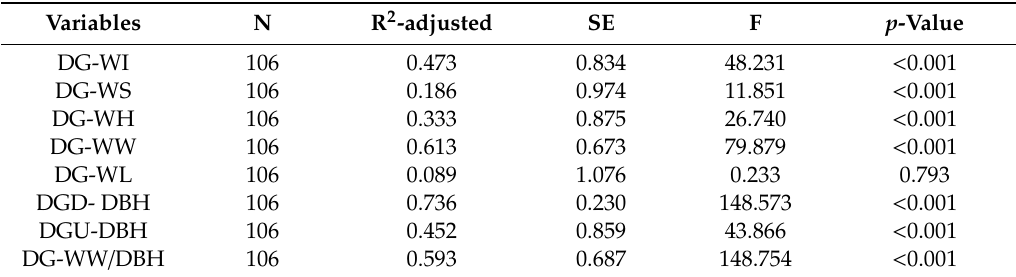
Table 6. Results of regression analysis between characteristics of wounds and trees with diameter growth in loblolly pine trees (WI: wound intensity, WS: wound size, WH: wound height, WW: wound width, WL: wound length, DGD: diameter growth of damaged trees, DGU: diameter growth of undamaged trees), SE: standard